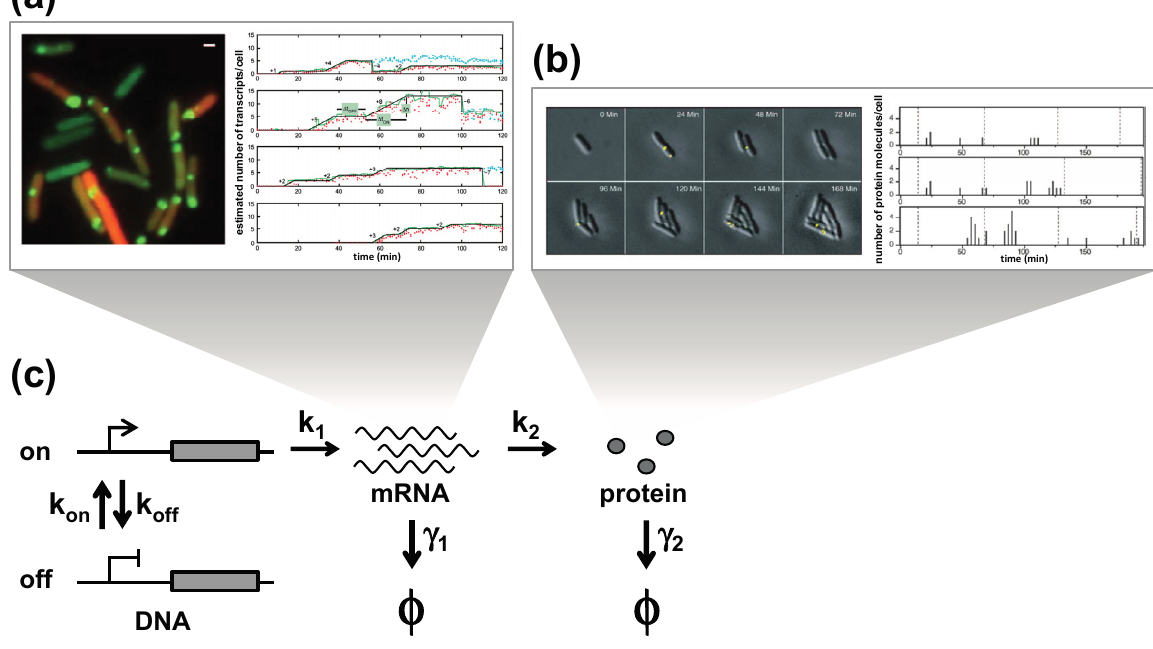
Figure 2. Stochastic gene expression. ( a ) Experimental observations of transcriptional bursts. Expressions of mRNA molecules in single E. coli cells are visualized in real-time by labeling the MS2-GFP system [19]. Each green spot consists of one or more mRNA molecules ( left ). Time trace of mRNA expression in single cells ( right ). ( b ) Experimental observations of translational bursts. The expression of proteins labeled with Venus in single E. coli cells are visualized in real-time. Venus molecules are photobleached immediately after the image acquisition so that only newly synthesized proteins are imaged each time [10]. Each yellow spot represents single protein molecules ( top ). Corresponding time courses ( bottom ). ( c ) Model for stochastic gene expression. The promoter transitions between an inactive ‘off’ state and an active “on” state with rates k on state, mRNAs are transcribed at the rate of k mRNAs and proteins are degraded at the rates γ degraded mRNAs and proteins are indicated as ϕ . Images are taken from